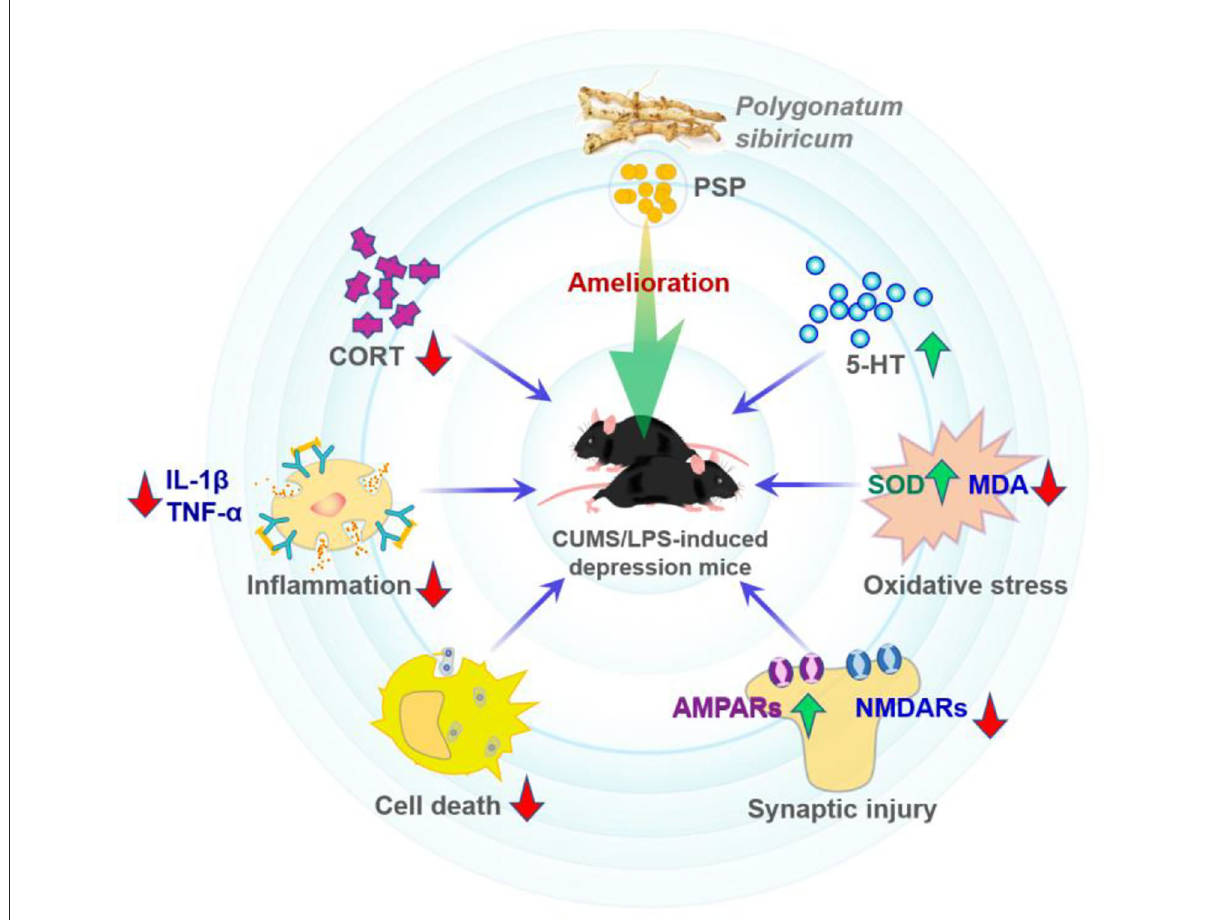
FIGURE7 Possible amelioration mechanisms of depression-like behaviors by PSP